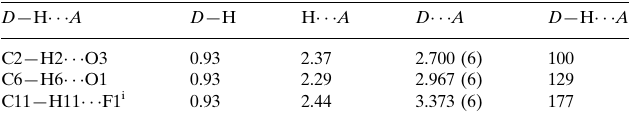
Hydrogen-bond geometry (A˚ , (cid:3) ).